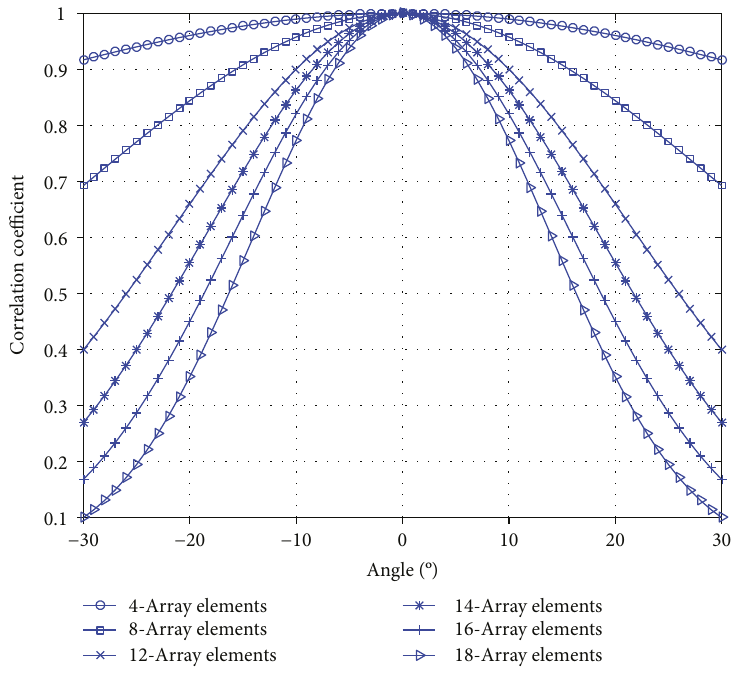
Figure 2: Array correlation coe ffi